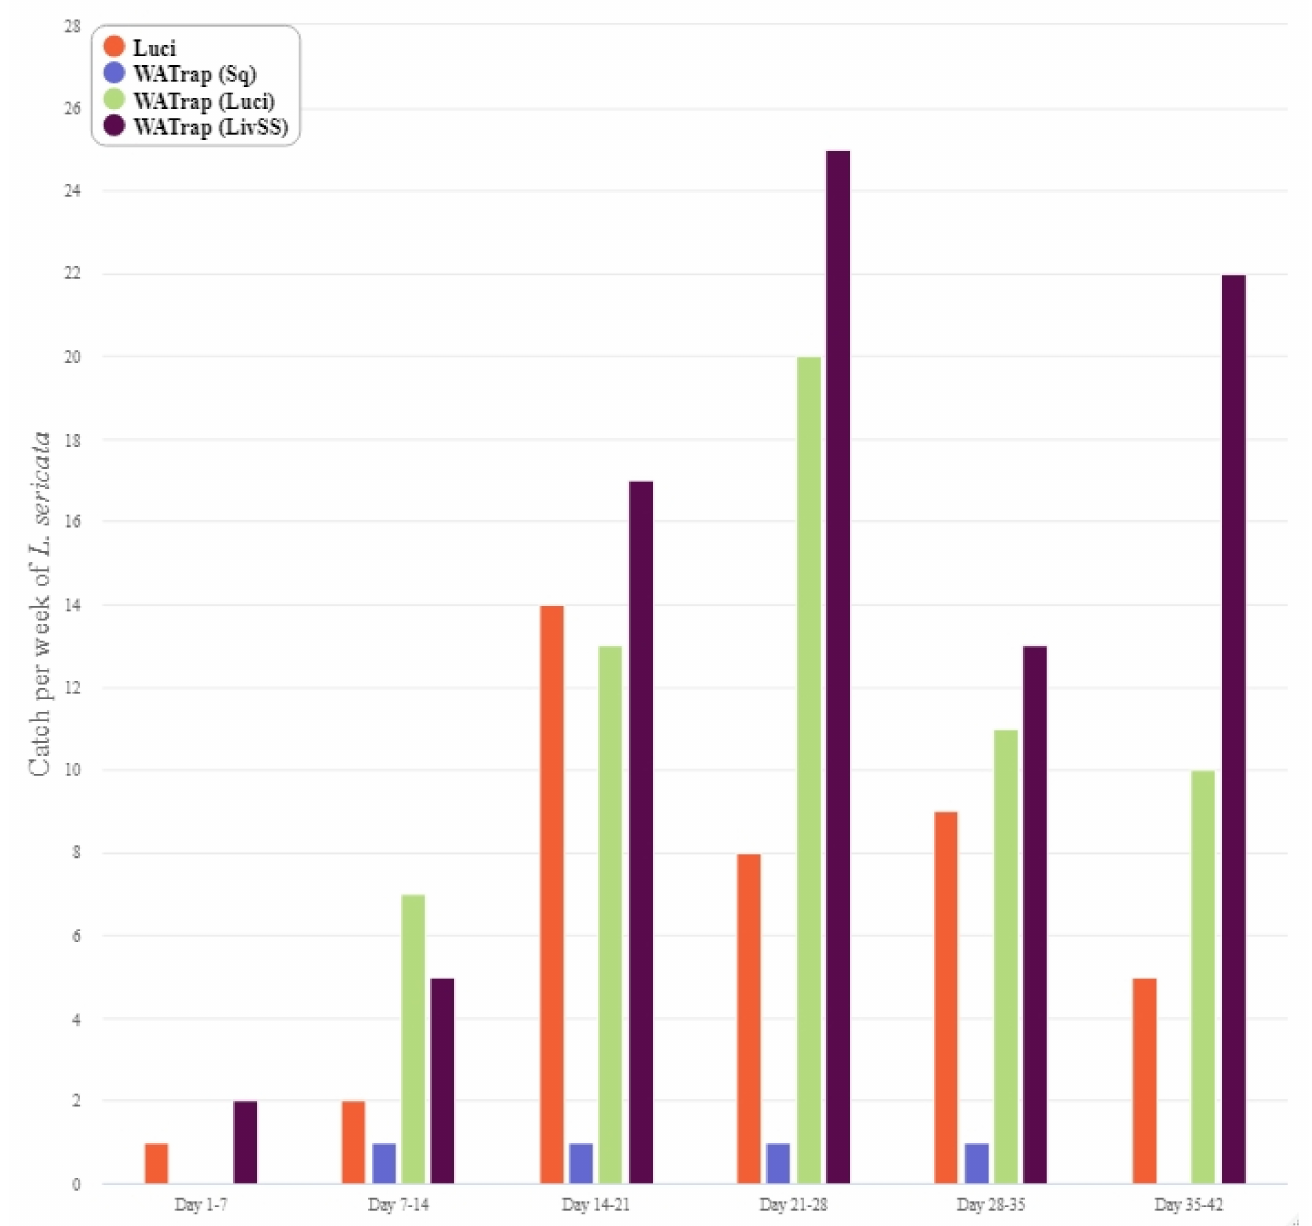
Figure 5. Weekly catch of Lucilia sericata using the four different trap types: LuciTrap with LuciLures A, B and C, (Luci); Western Australian Trap with squid, (WAT (Sq)); Western Australian Trap with LuciLures A, B and C, (WAT (Luci)); and Western Australian Trap with Sodium Sulphide and sheep liver, (WAT